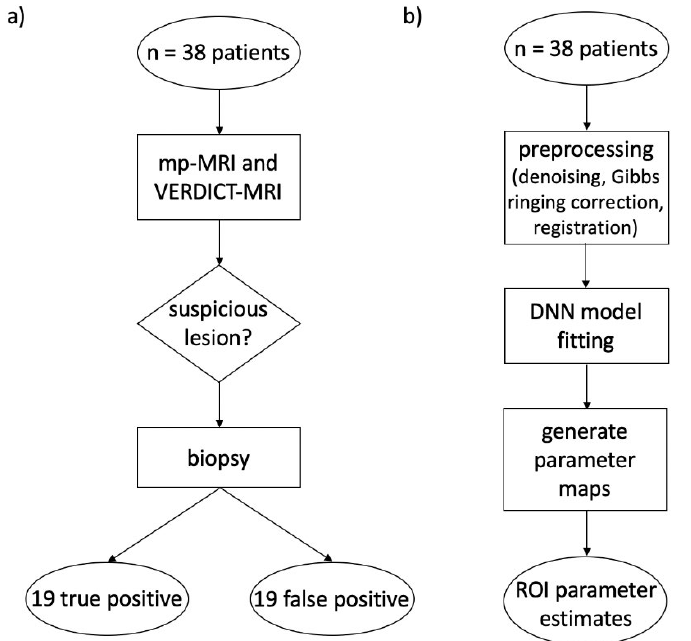
Figure 1. Flowcharts describing full methodology of study. ( a ) Image acquisition pipeline to deter- mine nature of patient lesion. ( b ) Image analysis pipeline for deep learning parameter estimation used to fit IVIM, DKI and VERDICT models.